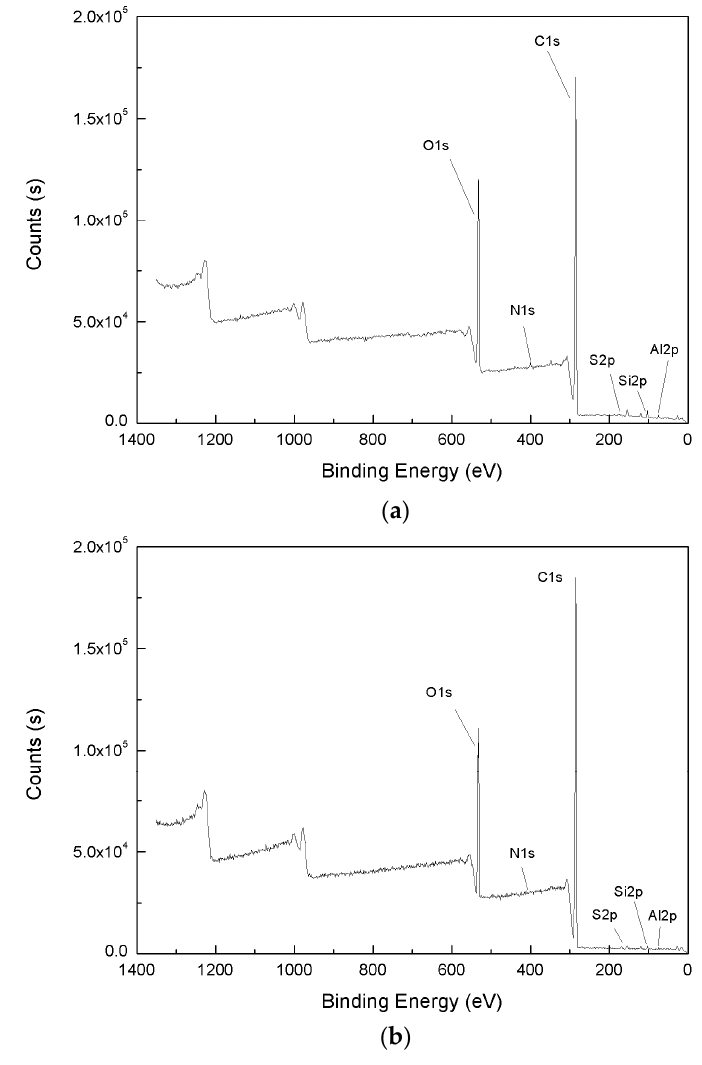
Figure 2. XPS survey scans of the coal surface before ( a ) and after ( b ) adsorption of NPEO 10 .